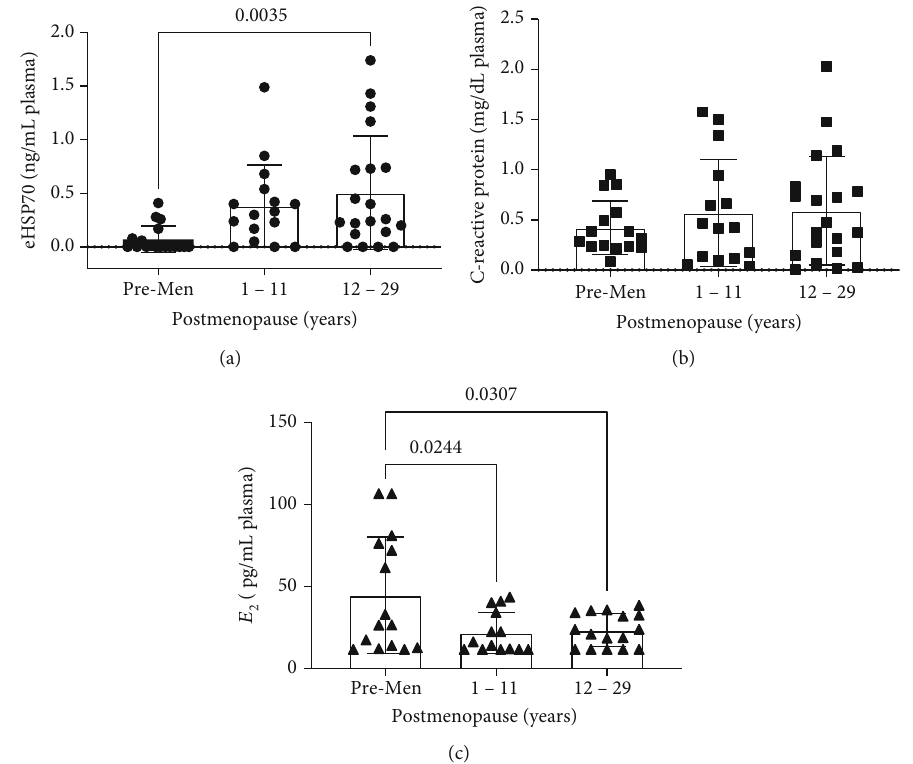
Figure 3: (a) eHSP7; (b) C-reactive protein (CRP); and (c) 17 β -estradiol (E2) levels, in premenopausal (premen) ( n = 15 – 18 ) and postmenopausal women 1 to 11 years ( n = 14 – 16 ) and 12 to 29 years of postmenopause ( n = 17 – 20 ). One-way ANOVA, followed by Tukey. a vs. premenopausal woman, p < 0 : 05